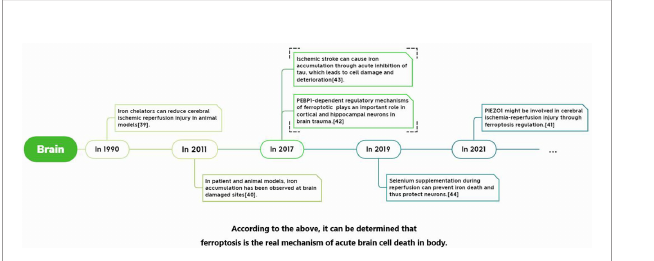
FIGURE 5 | Report of Ferroptosis in liver and kidney ischemia-reperfusion